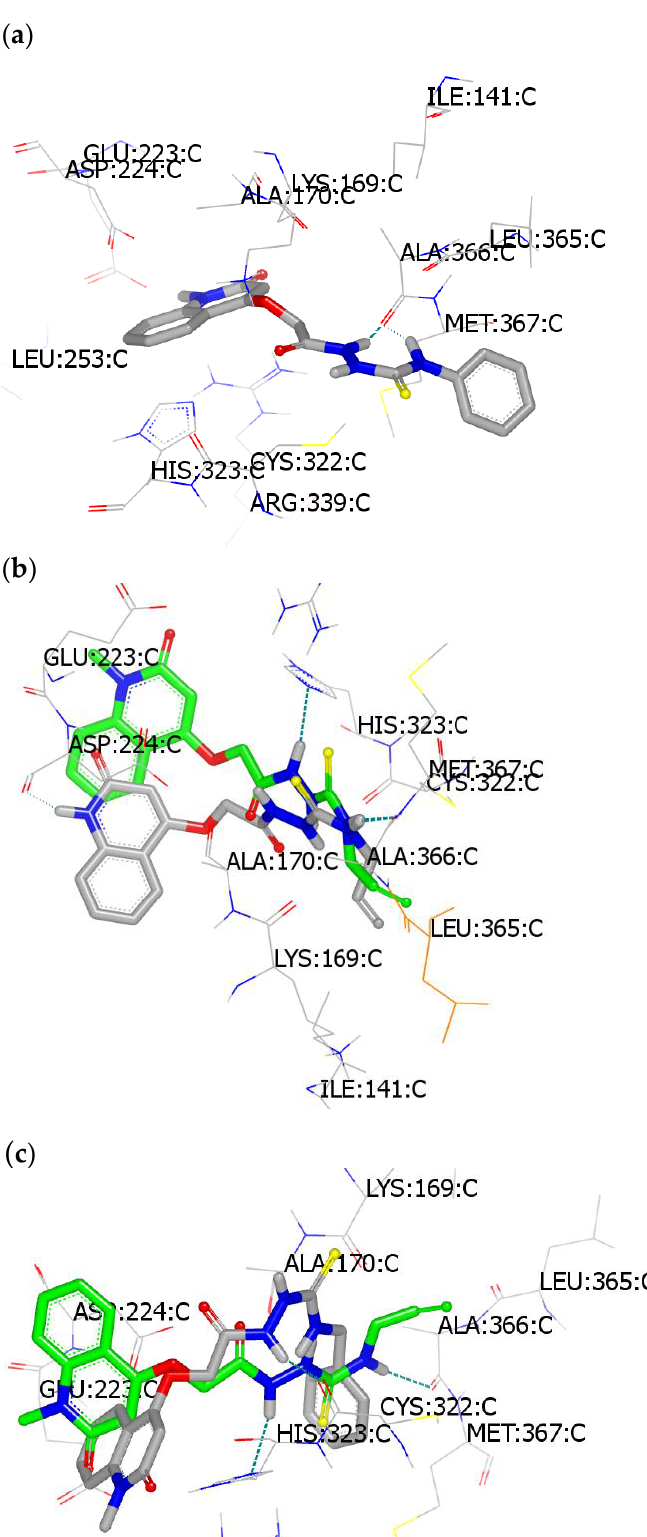
Figure 4. Visualization of compounds docking with PDBID: 4uBP: ( a ) compound 5c ; ( b ) compounds 5a and 5f ; ( c ) compounds 5b and 5a. Table 3. Docking mode and consensus scores for compound 5a – g .